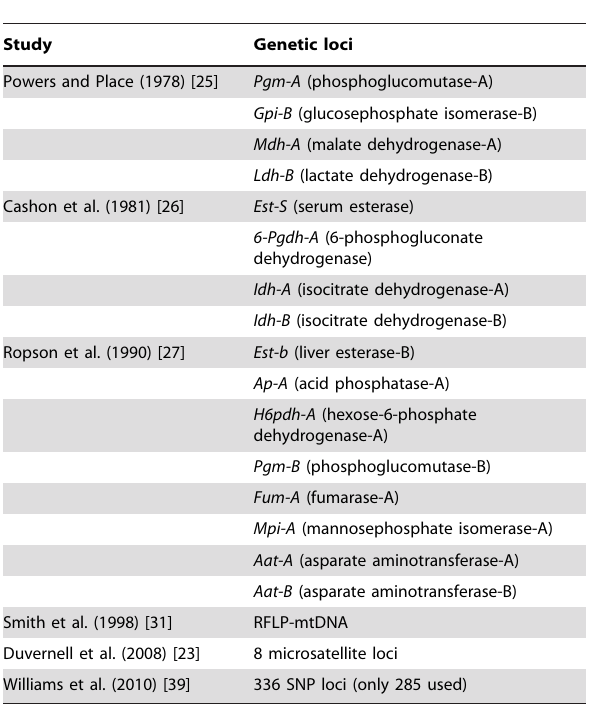
Table 1. Sources and types of data employed in this study.